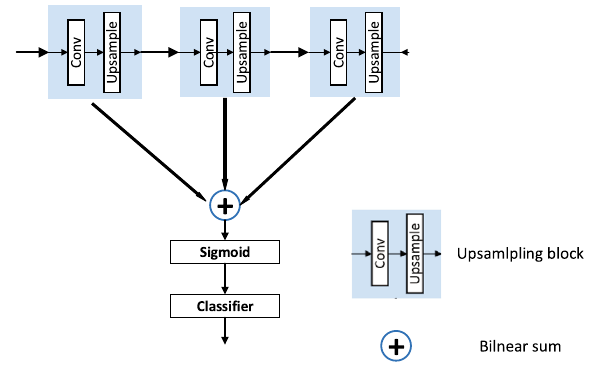
Figure 8. Hypercolumns